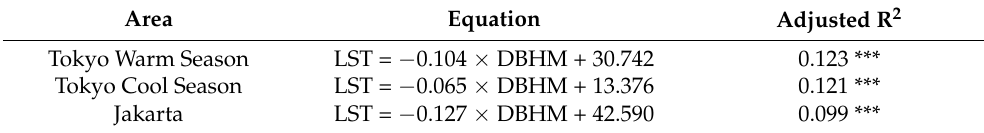
Table 3. Regression results of land surface temperature (LST) and digital building height model (DBHM). *** p -values less than 0.001.